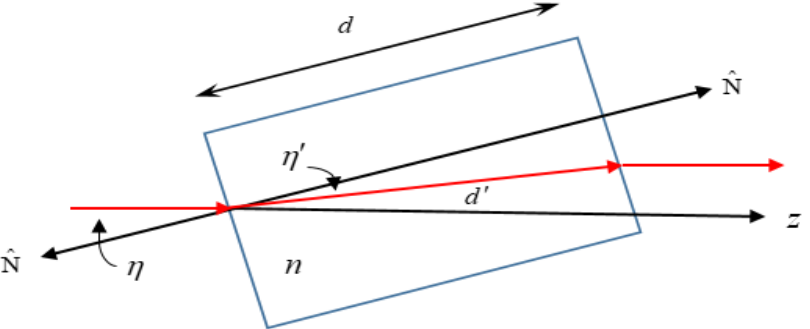
Figure 3. The schematic for illustrating light trajectory when the quartz block rotates.